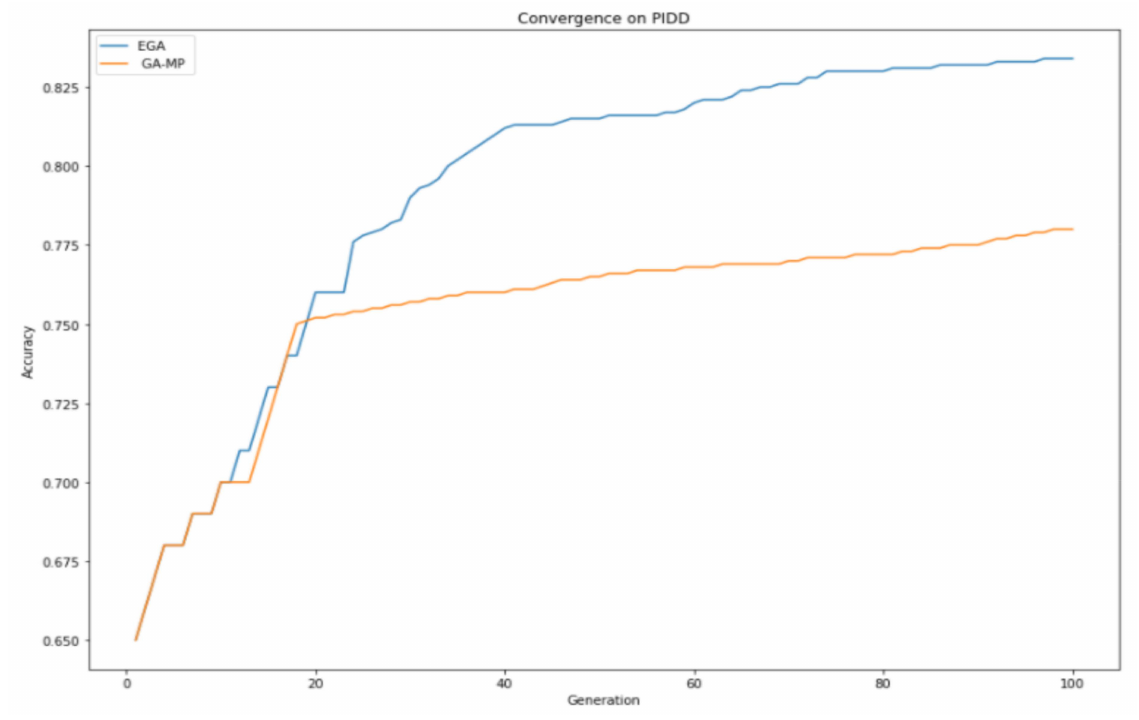
Figure 4. Convergence on PIDD.